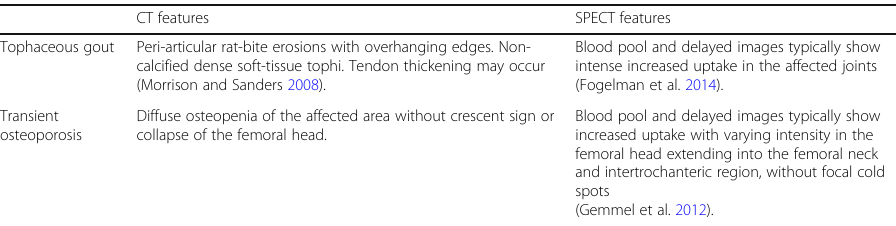
Table 1 Overview of imaging features in potential applications of bone SPECT/CT in the limping patient